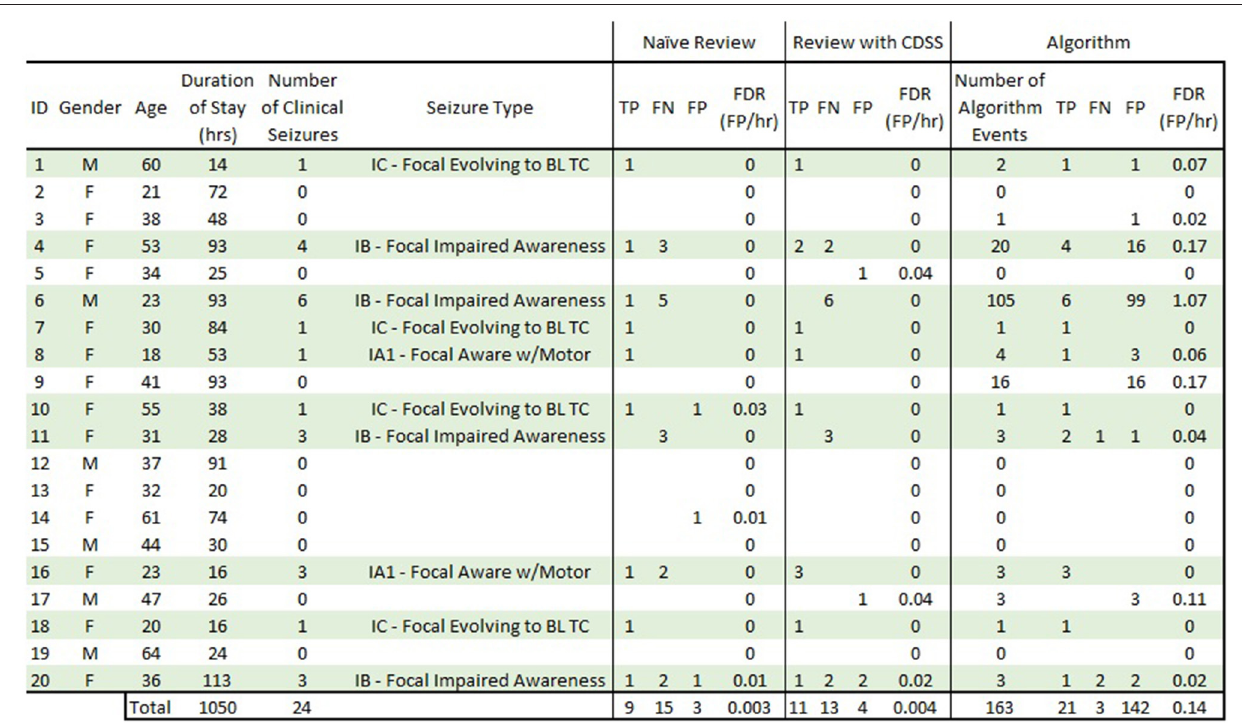
TABLE 1 | Summary of sensitivity, precision, and false detection rate results.